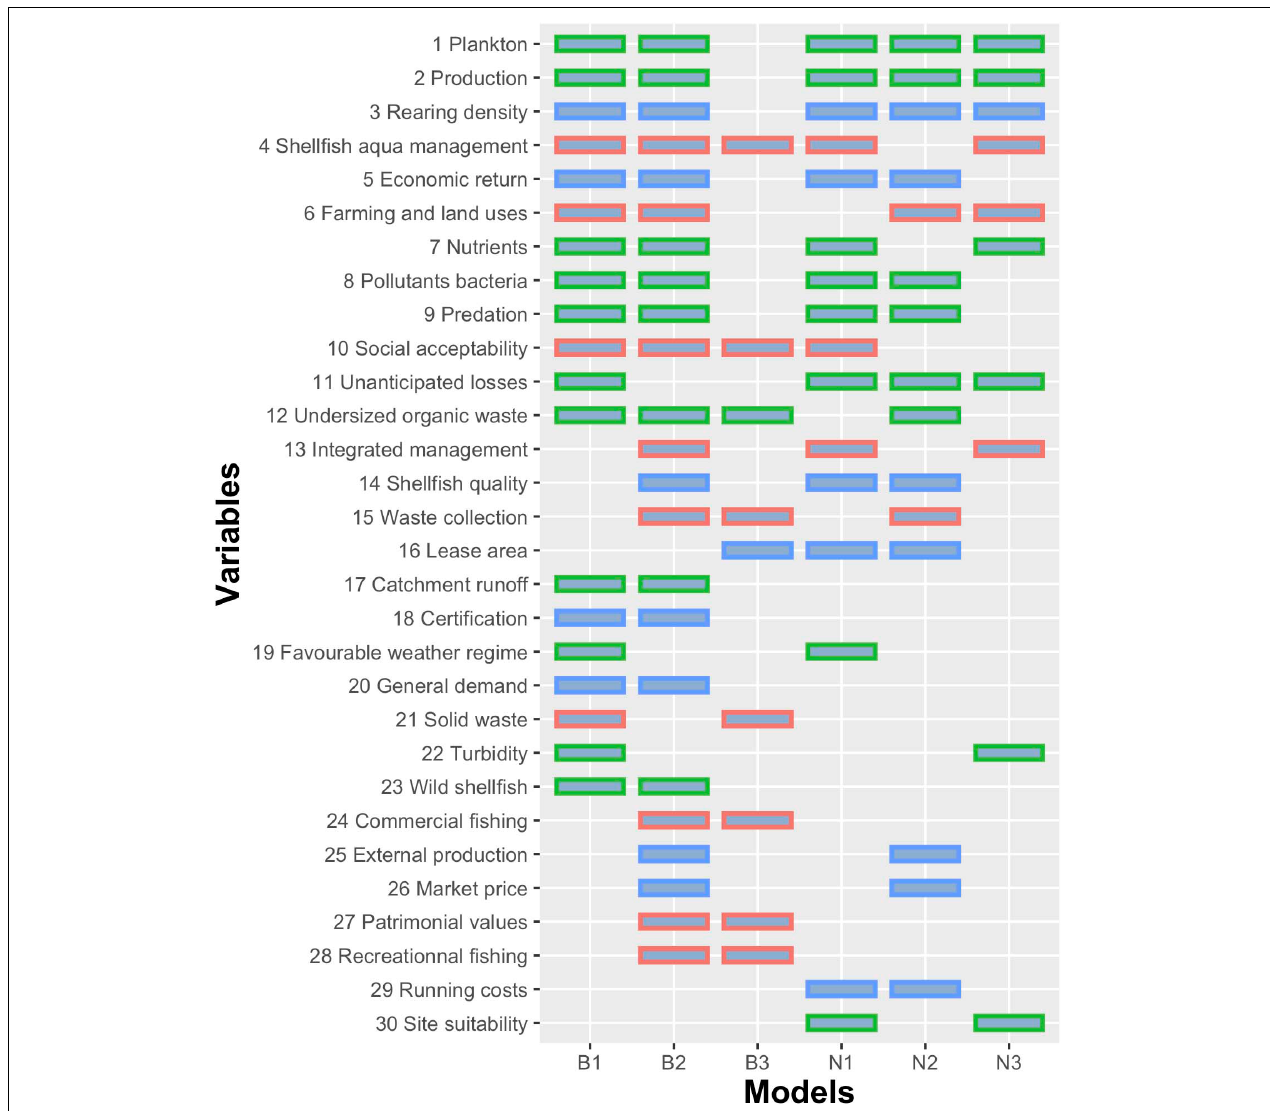
FIGURE 2 | Variable inclusion across the six stakeholder models ranked from commonly- at the top (e.g., “plankton” included in five models) to rarely included at the bottom (e.g., “site suitability” included in only two models). Environmental variables are coded in green, economic variables in blue and social variables in red. This graph excludes variables that only appeared in one of the six stakeholder